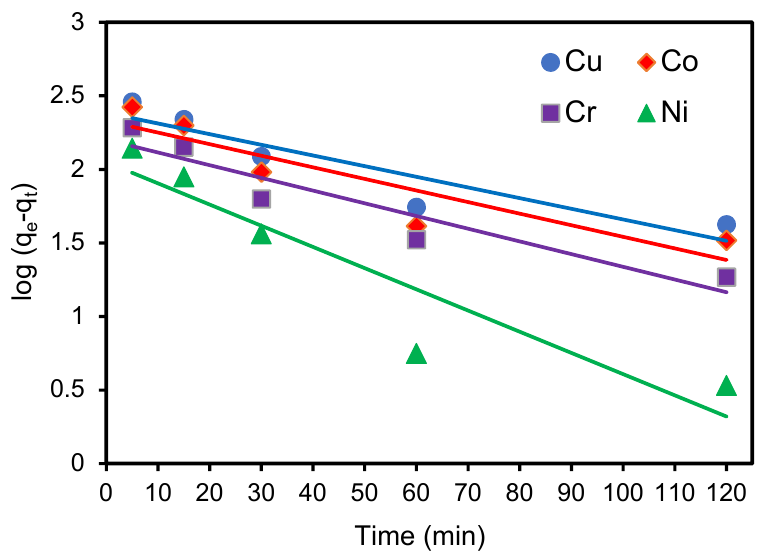
Figure 10. Pseudo-first-order kinetic plots of metal adsorption by polymer ligand; experimental conditions: 100 mg of poly(hydroxamic acid), 10 mL of 0.1 M CH 3 COONa buffer solution, and 5 mL of 0.1 M heavy metal solution at pH 6 agitated for 2 h.